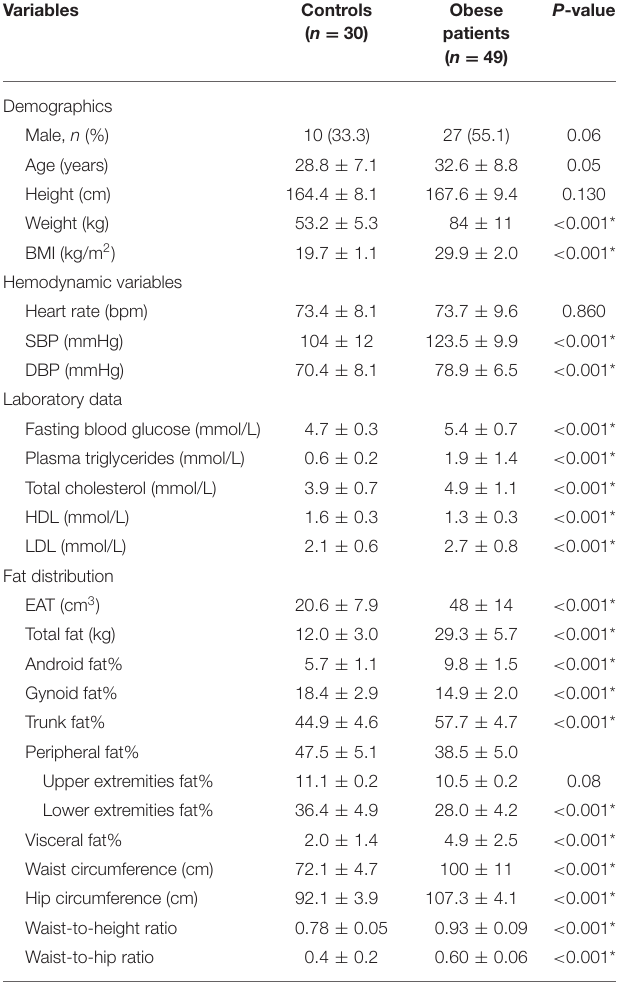
Multivariable linear regression analysis demonstrated that android fat% was independently associated with longitudinal PS